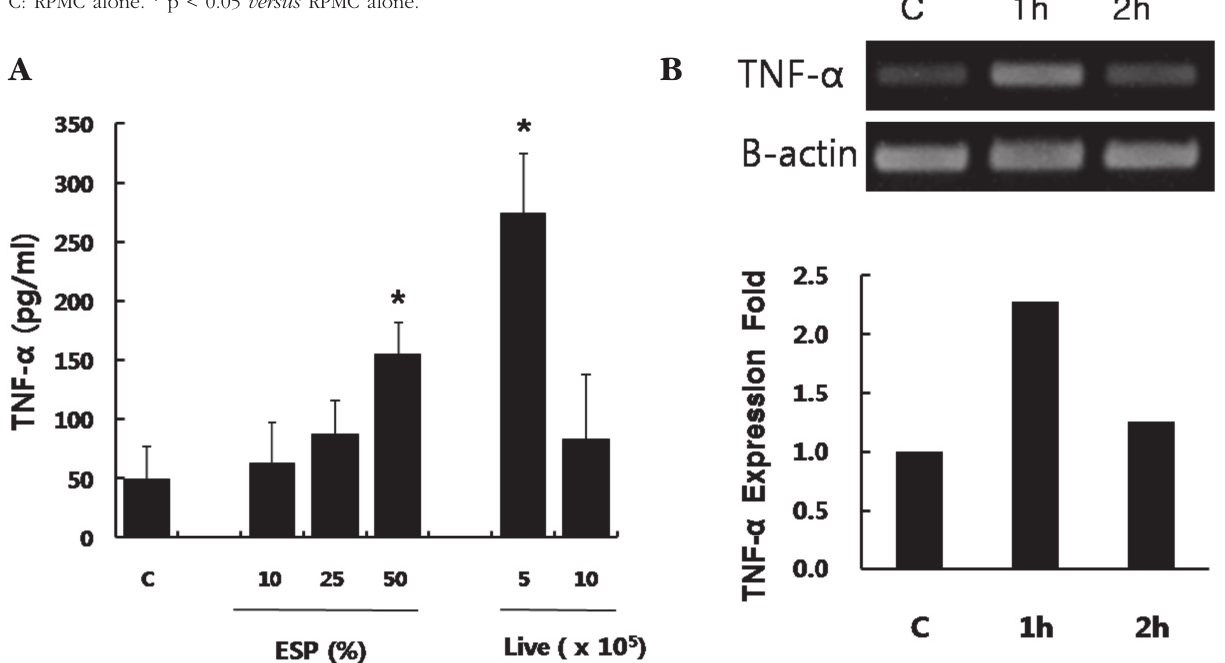
Fig. 3. – (A). TNF- α production induced by rat peritoneal mast cells stimulated with T. vaginalis (excretory-secretory products of T. vagi- nalis , and live trichomonads) for 6 h. * p < 0.05 versus RPMC alone. C: RPMC alone. (B) TNF- α mRNA expression of RPMC stimulated with 50 % ESP of T. vaginalis for 1 h or